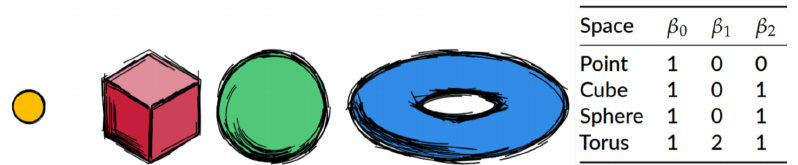
Figure 4. Different objects and their first Betti numbers (the cube, sphere, and torus are empty). Figures from